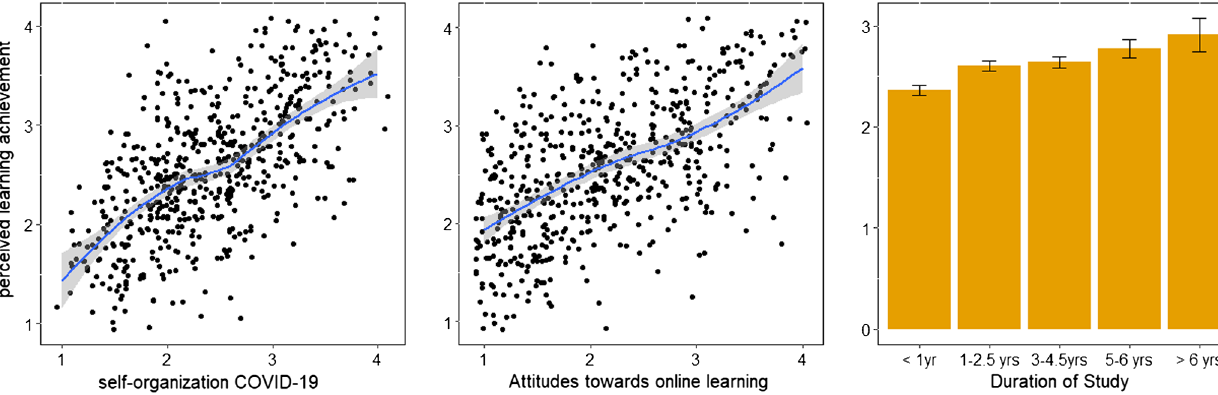
FIG. 2. Scatter plots of learning achievement versus self-organization abilities during the COVID-19 pandemic (left) and student attitudes toward online learning (center), including a smoothed fit curve with confidence region. A small jitter was added to the data points to avoid overlapping. High values represent high success or abilities. Right: Learning achievement (perceived by the students) versus duration of study. The error bar represents the standard error of the mean.